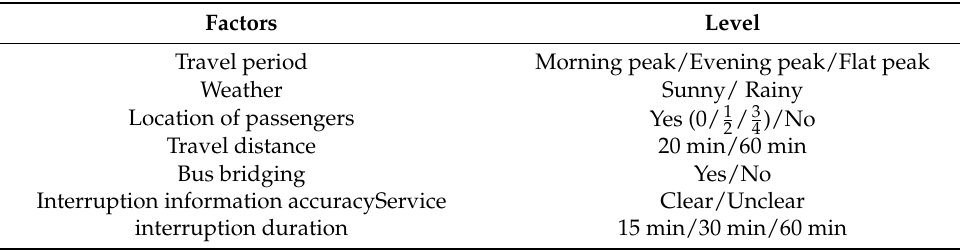
Table 2. Scene variation of the SP